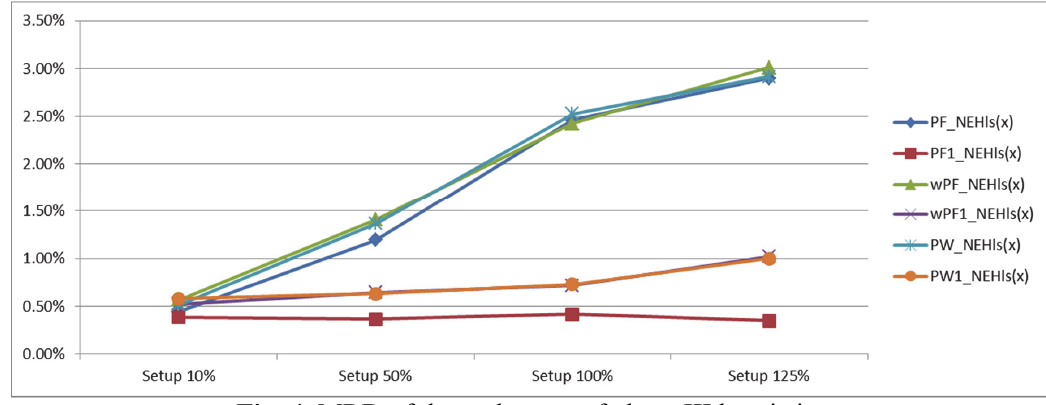
Fig. 4. MRD of the makespan of phase III